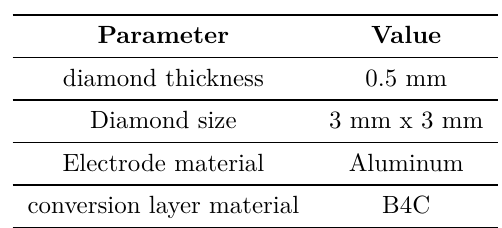
Table 2. Parameters of the diamond